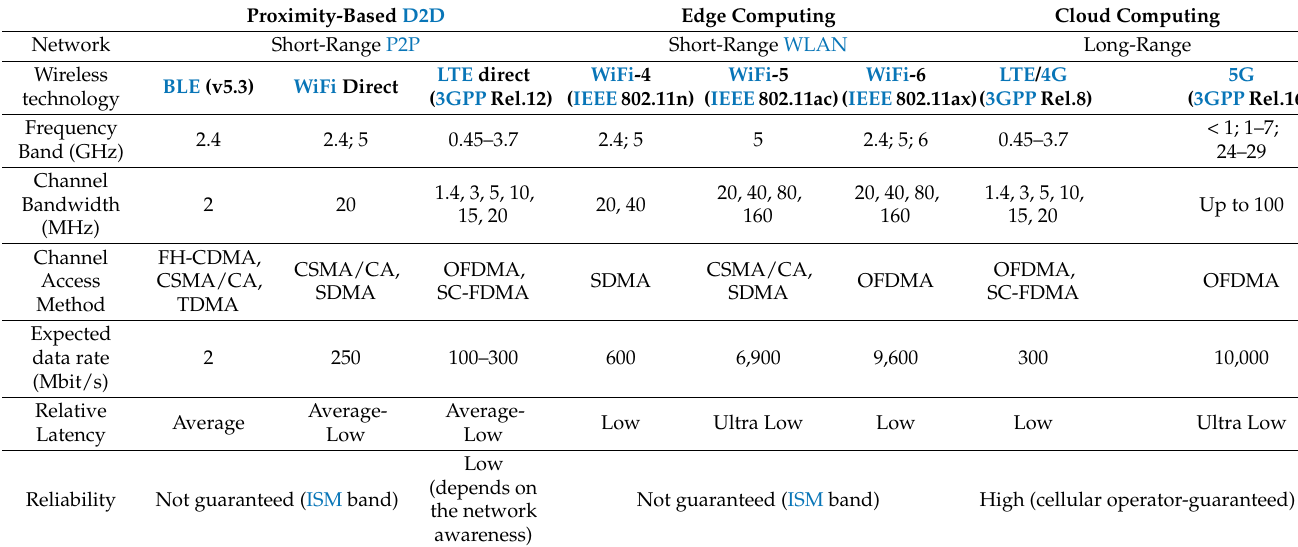
Table 4. Showcasing a few relevant technologies for D2D, Edge, and Cloud computing [124–131]. Proximity-Based D2D Edge Computing Cloud Computing Short-Range